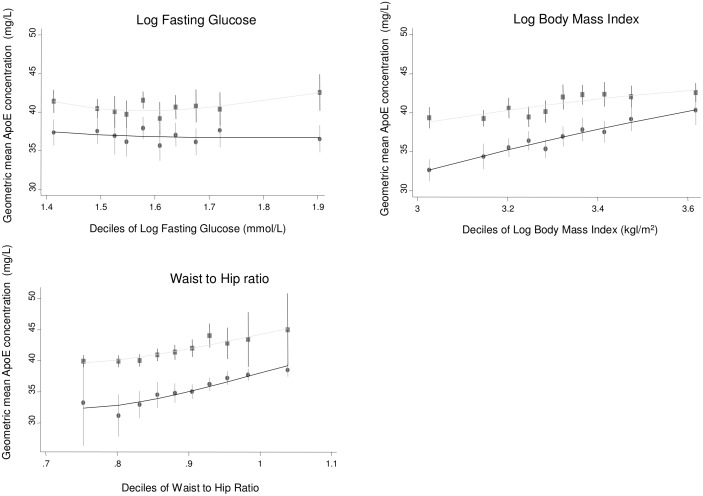
Cross-sectional association between geometric mean of ApoE concentration and glucose, body mass index, and waist-to-hip ratio measured in ELSA, by gender.Male (circles) and female (square) mean log ApoE concentration was calculated for each decile of the associated variable and plotted to visualise the shape of the association. Bars give 95% CIs.